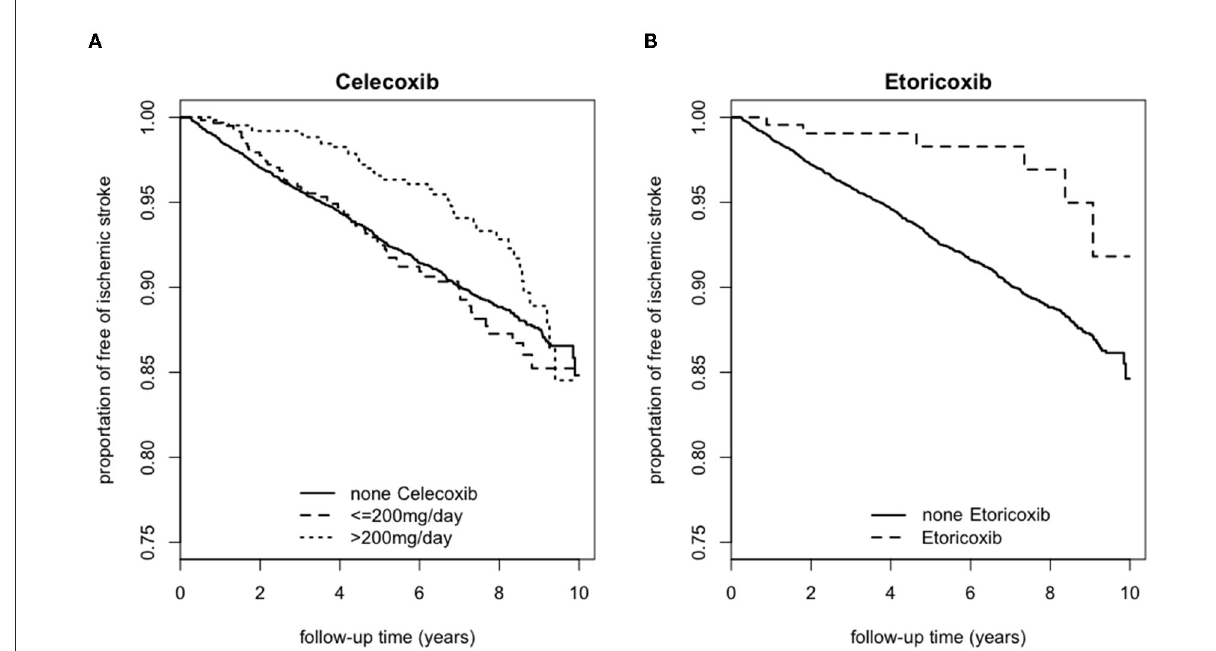
FIGURE2 Kaplan Meier survival curve for those with ischemic stroke according to usage of (A) Celecoxib or (B) Etoricoxib over a 10-year follow-up period.